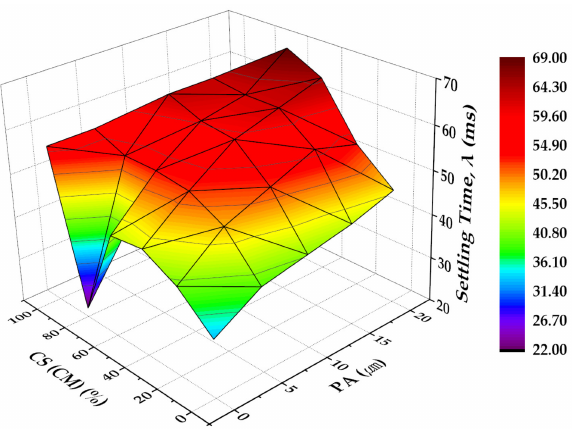
Figure 21. Settling time ( λ ) vs. CS and PA . Table 9. Convergence yaw angle for combinations of PA and CS